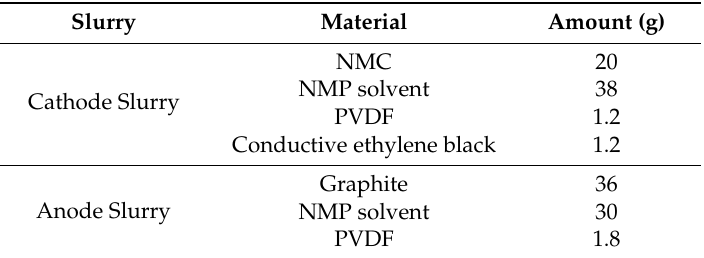
Table 1. Mixing formulations of the cathode and anode slurries. NMC, Nickel manganese cobalt